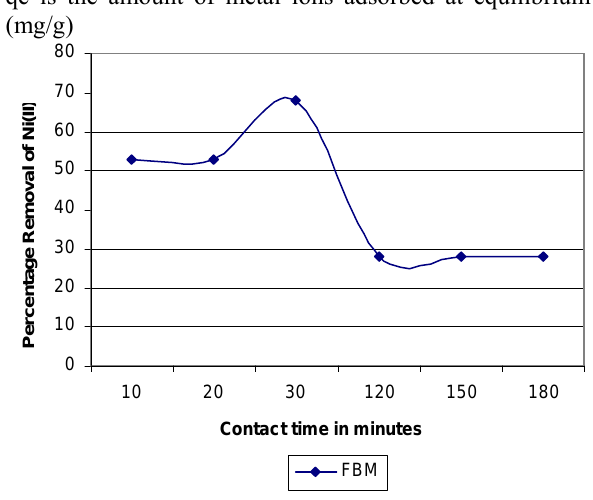
Figure 4: Effect of contact time on biosorption of Ni(II). Values calculated based on above equation and graph plotted between log (qe-q) and time in minutes follow a linear relation which indicates that the kinetics of biosorption of Ni(II) was of first order kinetics (Fig 5).